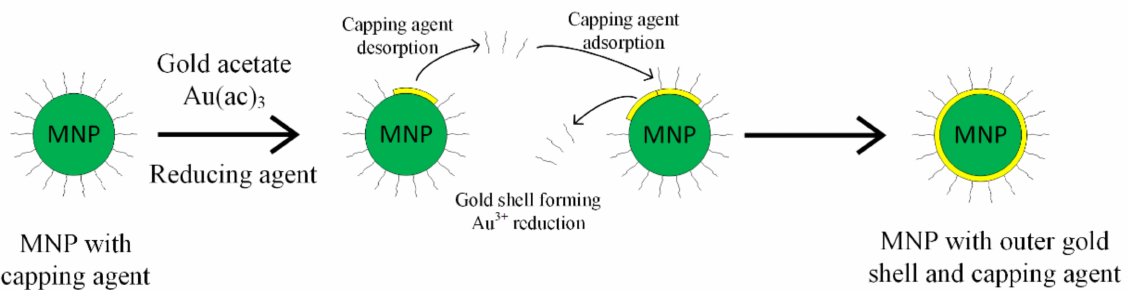
Figure 4. Capping agent desorption and gold coating